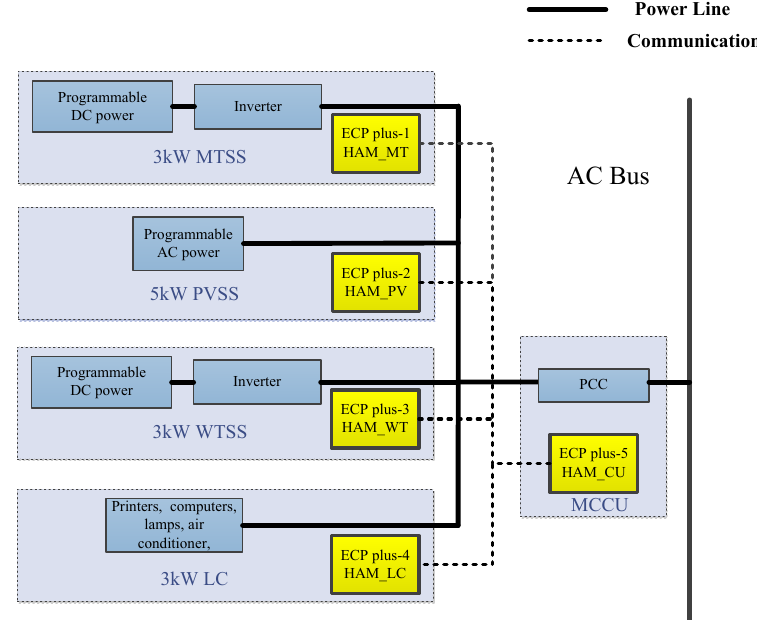
Figure 8. Laboratory test system for HAMs. MTSS: micro-turbine generation simulation system; PVSS: photovoltaic generation simulation system; WTSS: wind turbine generation simulation system; and MCCU: measurement and control